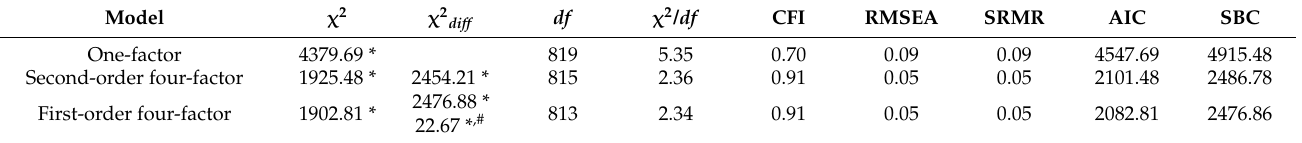
Table 6. CFA goodness-of-fit indicators.